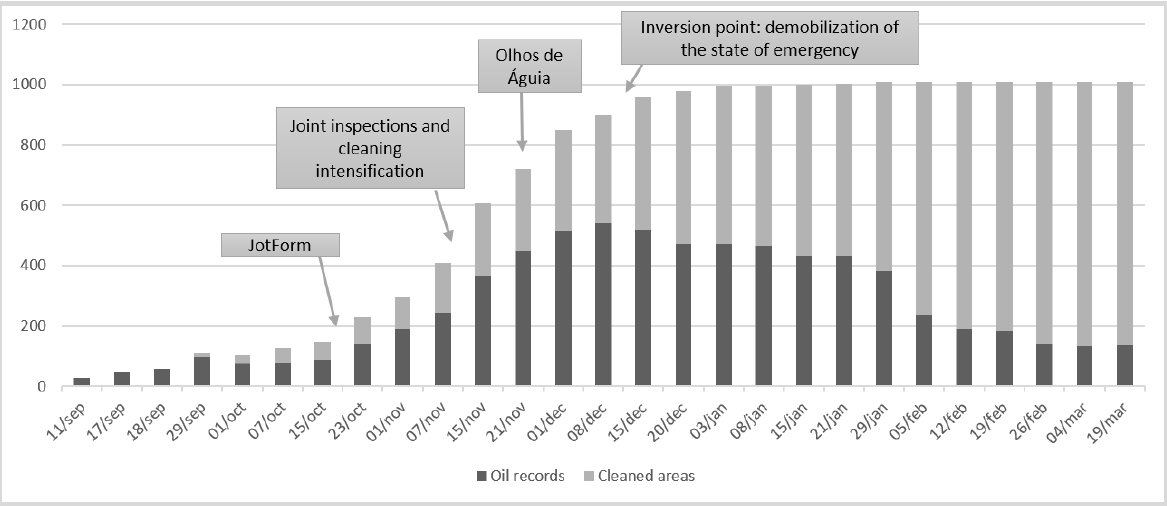
Figure 5. Clean vs oiled localities – 09/11/2019 to 03/19/2020. Chart elaborated with data from the “Oiled Areas” maps (Ibama